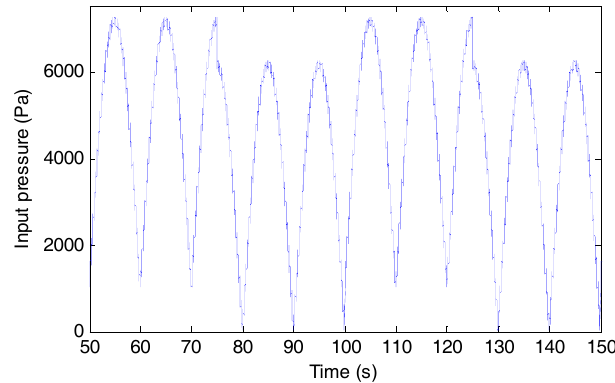
Figure 11. Input pressure waveform for irregular waves [27].